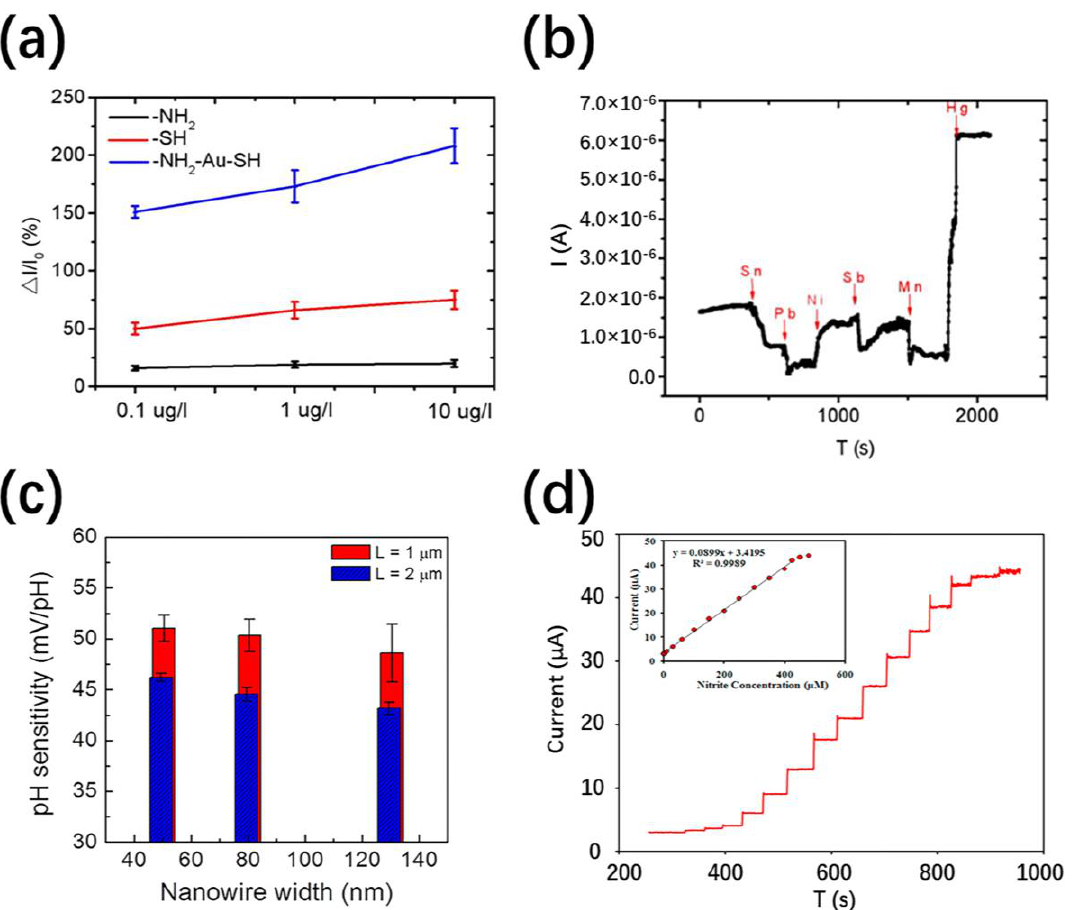
Figure 6. ( a ) △ I/I 0 as a function of mercury ion concentration for different modified SiNW devices [83]; ( b ) real-time current response to various metal ions of 10 μg/L −1 [83]; ( c ) the pH sensitivity of nanowires with different widths and gate lengths (L) of Effects of 1 and 2 μm [85]; ( d ) the current response of the Ag/halloysite nanotube (HNT)/MoS 2 -carbon paste electrode (CPE) to the nitrite with various concentrations. The inset shows the calibration curve of current versus nitrite concentration from 2 to 425 µ M